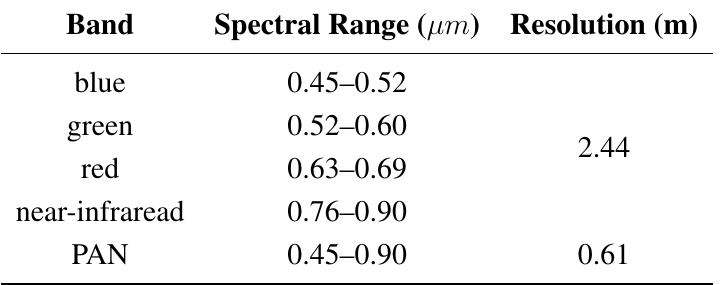
Figure 1. The study area is located in Valparaiso Region, Chile. The black star (on the right map) shows the location of the study site. Table 1. Spectral properties of the Quickbird